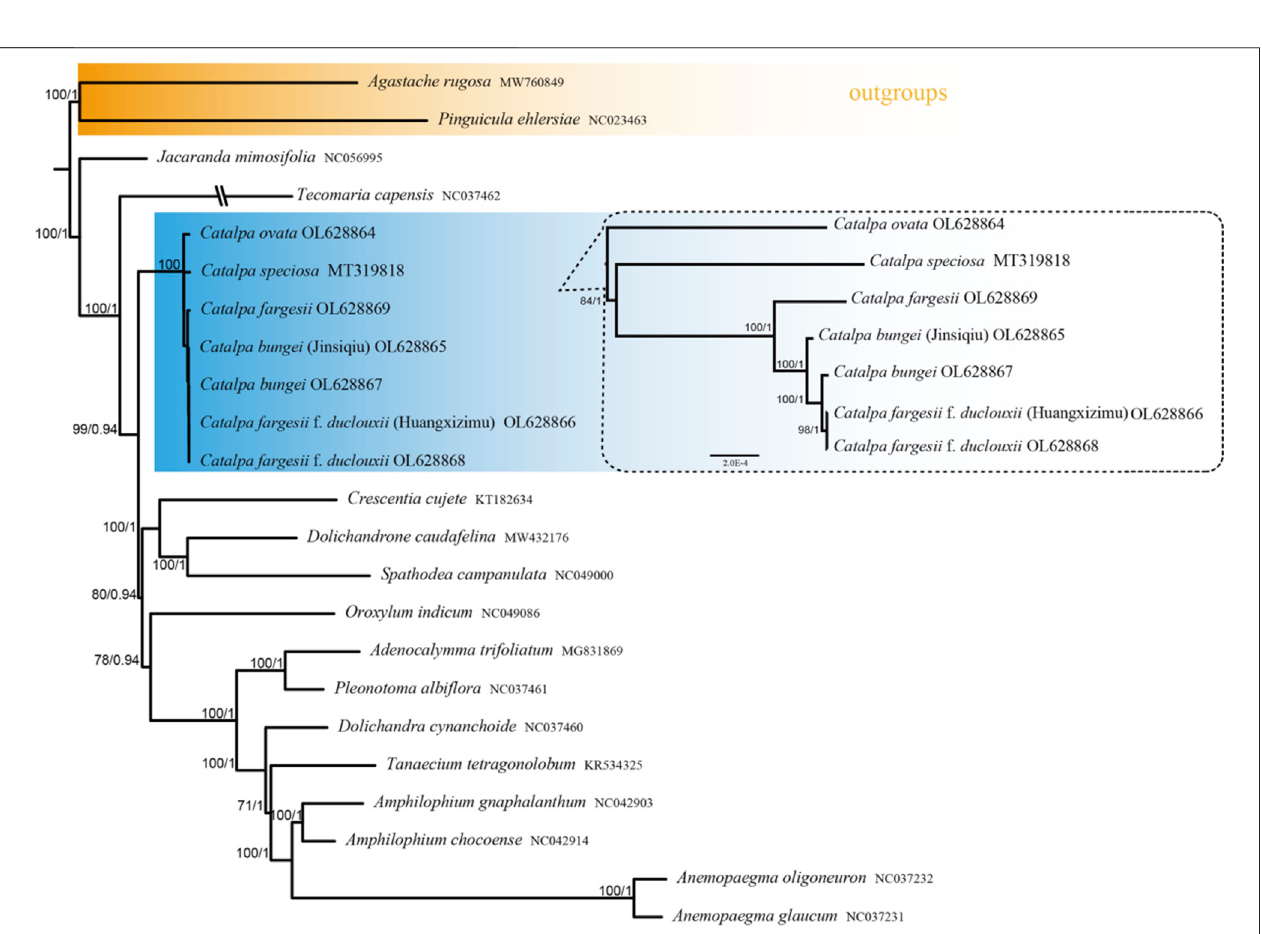
FIGURE8| Phylogenetictreeconstructed using the maximum likelihood (ML) and Bayesian inference(BI)methods basedon thewhole chloroplast genomesfrom 23 different species. The numbers above the branches represent the MI bootstrap values and Bl posterior probabilities.